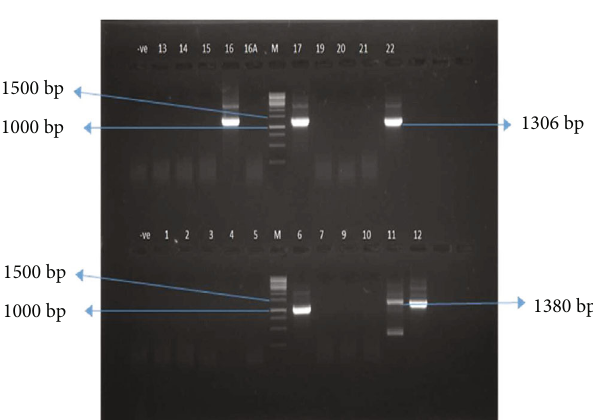
Figure 8: Gel photograph of nested PCR (2nd round) ampli fi cation of patients with imatinib resistance mutants. Lane M = 1kb DNA ladder (Thermo ™ SM#0323). Lane 6, 11, 12, 16, 17, and 22 = IM -resistant